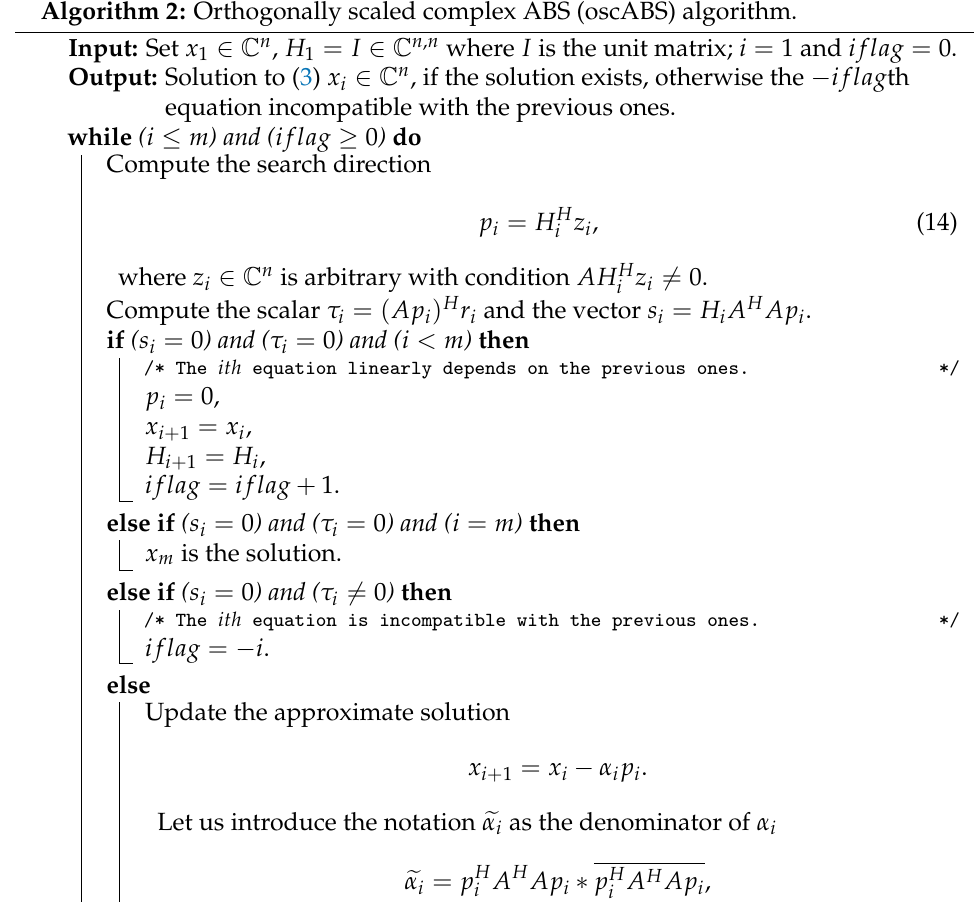
Algorithm 2: Orthogonally scaled complex ABS (oscABS)